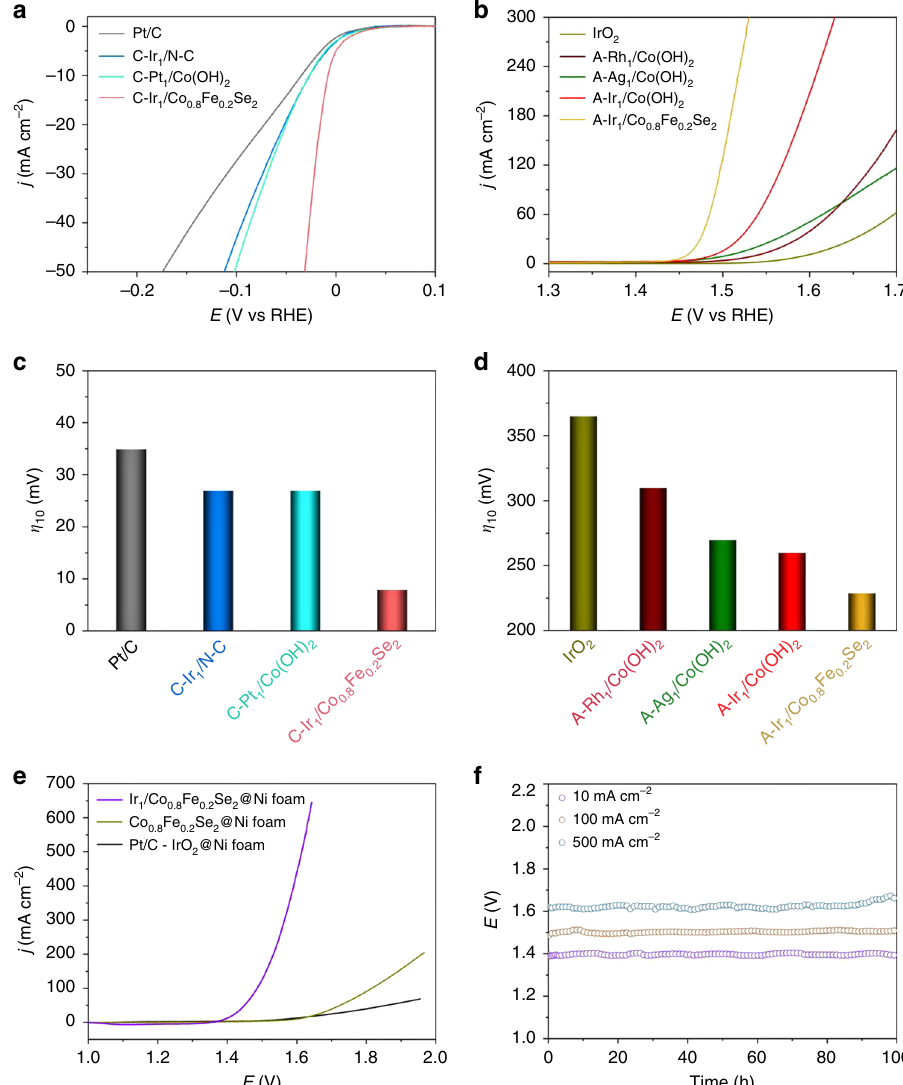
Fig. 4 Electrocatalytic performances of SACs for water splitting. a , b Polarization curves of cathodically deposited SACs for HER ( a ) and anodically deposited SACs for OER ( b ). The measurements were all conducted in 1 M KOH. c , d The overpotentials at 10 mA cm − 2 for HER ( c ) and OER ( d ). The commercial Pt/C and IrO 2 were used as references for HER and OER, respectively. e Polarization curves of Ir 1 /Co 0.8 Fe 0.2 Se 2 @Ni foam for overall water splitting in the two-electrode cell. The commercial Pt/C-IrO 2 coupled electrolyzer was used as a reference. f Chronopotentiometric curves of Ir 1 /Co 0.8 Fe 0.2 Se 2 @Ni foam for overall water splitting at 10, 100, and 500 mA cm − 2 for 100